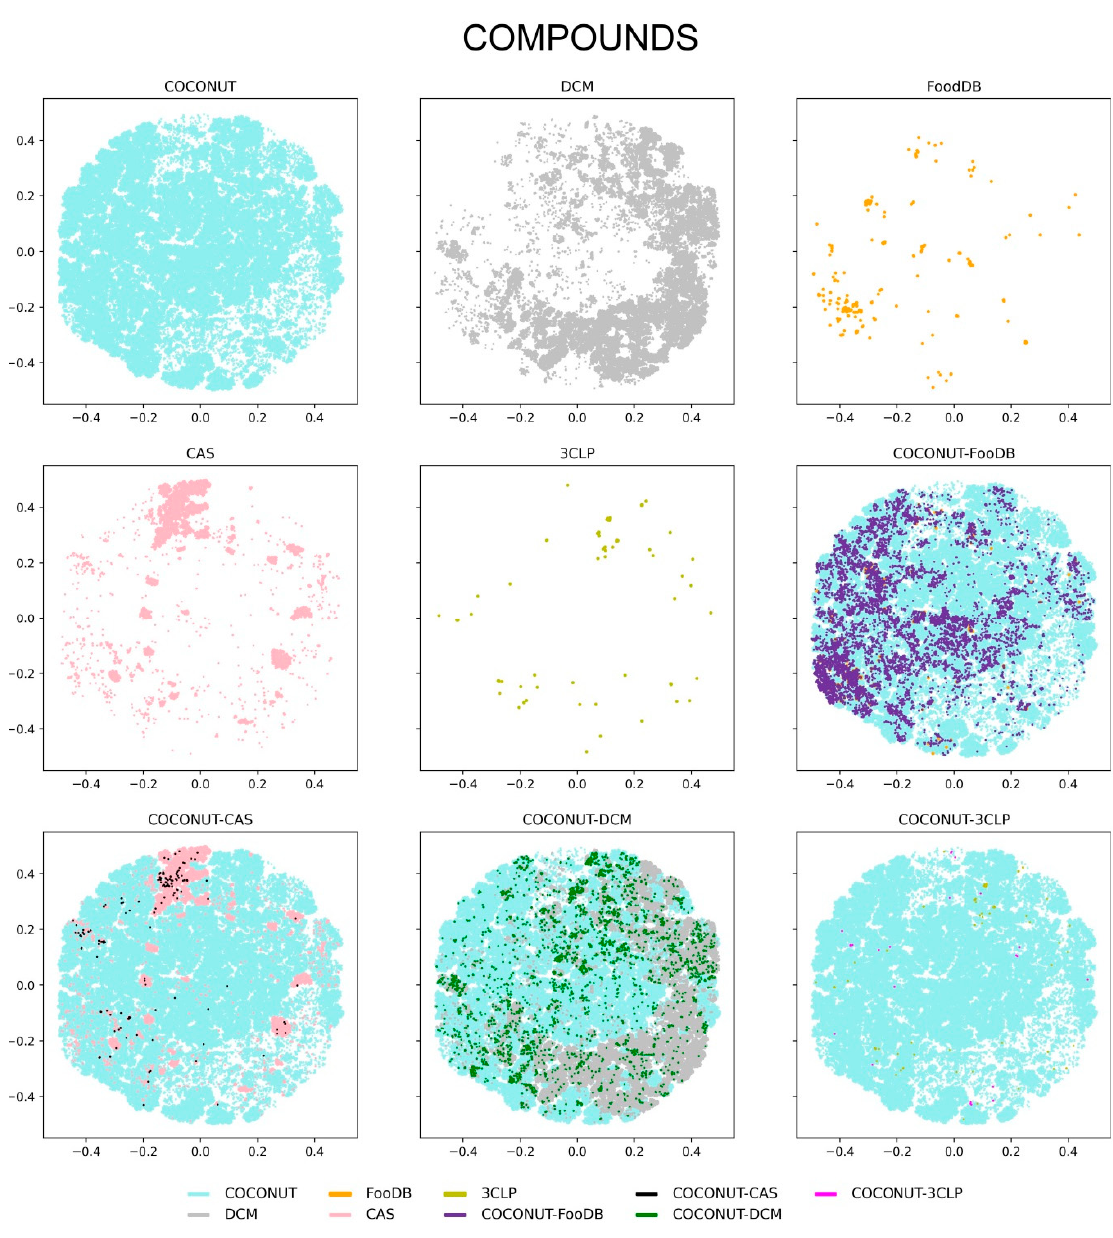
Figure 8. Visualization of the chemical space of the compound datasets generated with Tree Maps. Datasets are represented with colors: COCONUT (cyan), DCM (gray), FooDB (orange), CAS (pink), and inhibitors of the main protease of SARS-CoV-2, 3CLP, (olive). Overlapping compounds in COCONUT–FooDB (purple), COCONUT–CAS (black), COCONUT–DCM (green), and COCONUT–3CLP (magenta) are indicated.